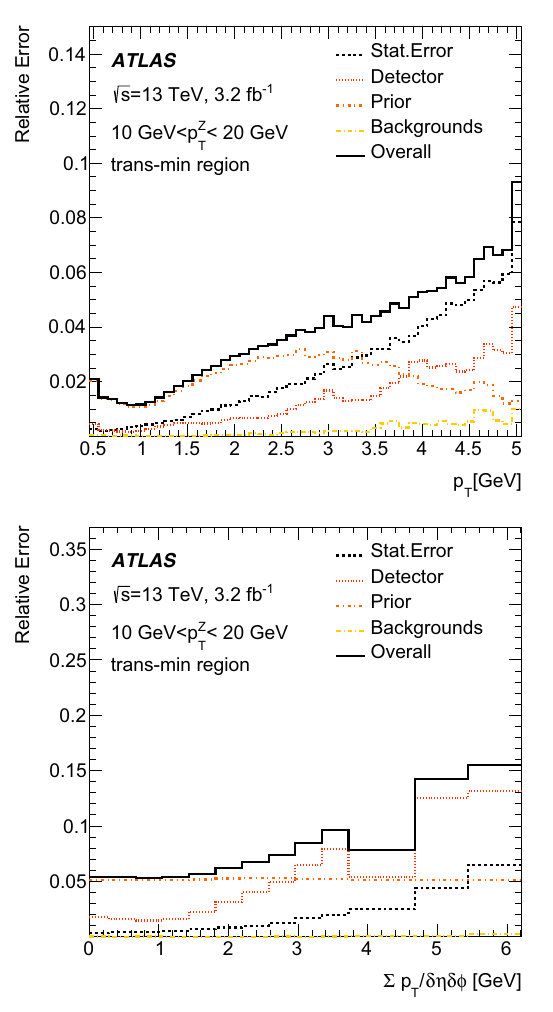
< 20 GeV in the trans-min region inclusively in T ⊥ . Here ‘Prior’ com- bines the two approaches to estimate the unfolding-related uncertain- ties. ‘Detector’ includes the modelling of the detector and the pile-up T